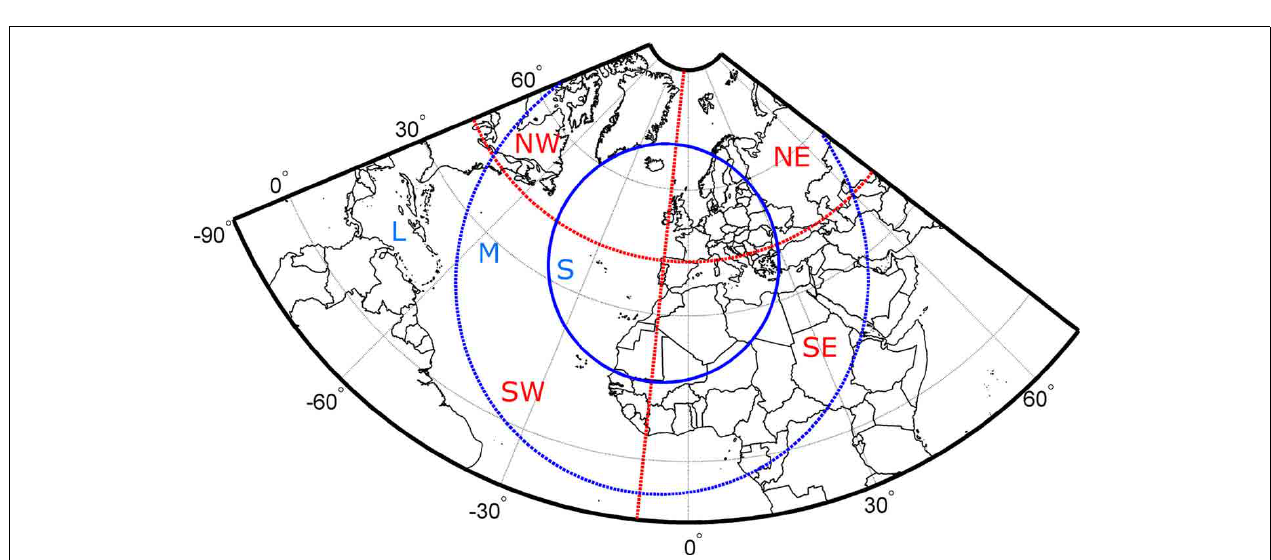
integrated absolute value of the curvature (ZI). For Q and D the tercile values are indicated with a dotted black line and for ZI the 50% percentile.